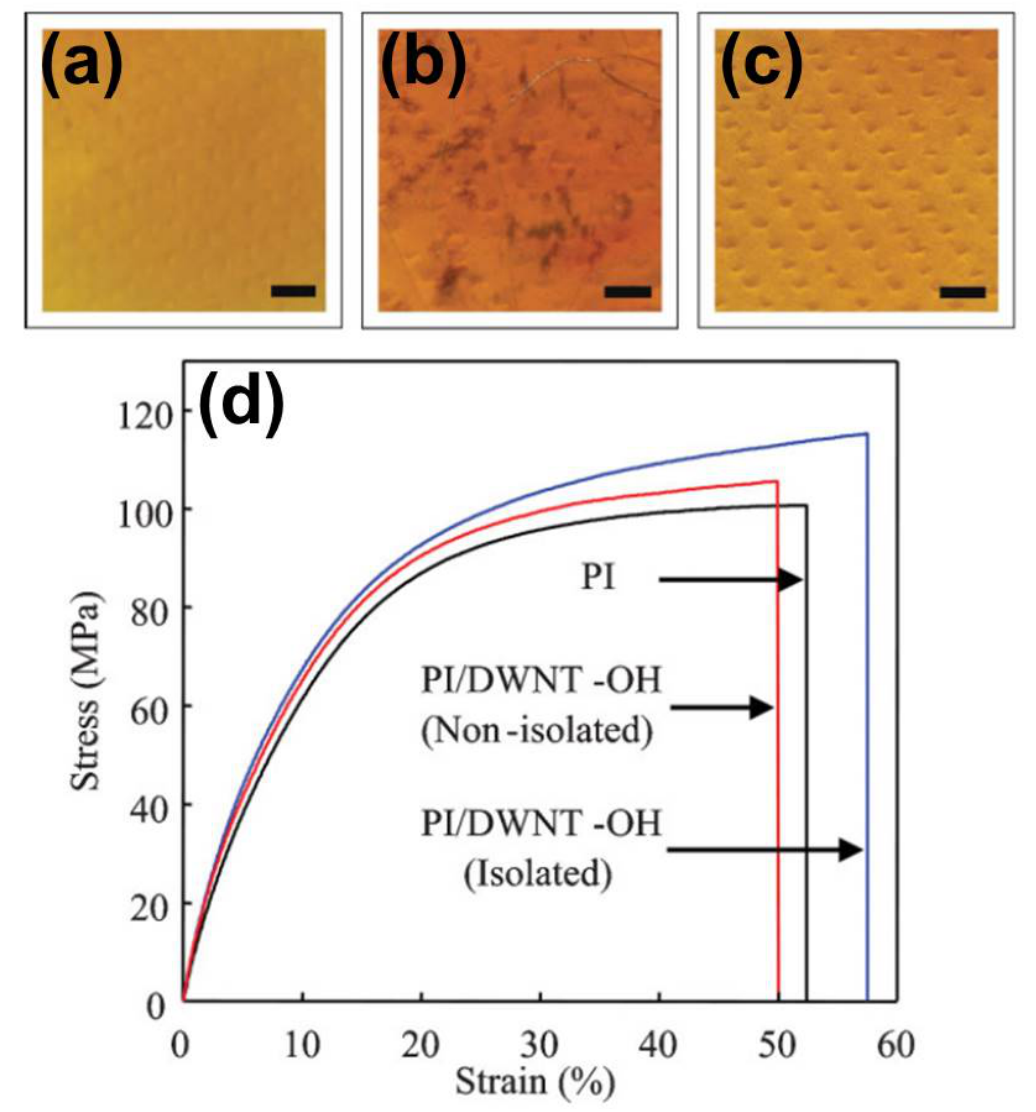
Figure 12. ( a ) Pure polyimide (PI) film, ( b ) polyimide/non-isolated DWNTs (PI/DWNT-OH non-isolated) film and ( c ) polyimide/isolated DWNTs (PI/DWNT-OH isolated) film. The non-isolated DWNTs perturb the transparency of the film. ( d ) Stress-strain curves of PI (black solid curve), PI/DWNT-OH non-isolated (red solid curve) and PI/DWNT-OH isolated (blue solid curve) . Reproduce with permission from [162], Copyright John Wiley and Sons,